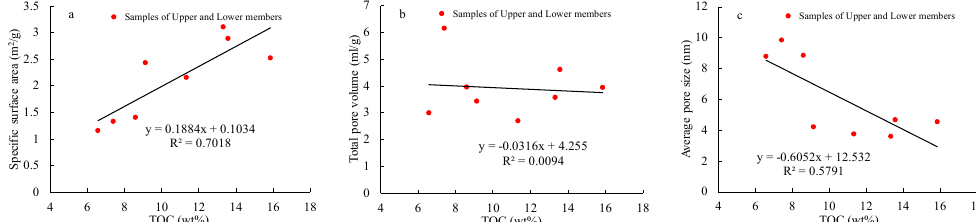
Figure 9. The relationship between total organic carbon content and pore structure parameters in the Upper/Lower Bakken samples. ( a ) Specific surface area vs. TOC; ( b ) Total pore volume vs. TOC; ( c ) Average pore size vs. TOC.